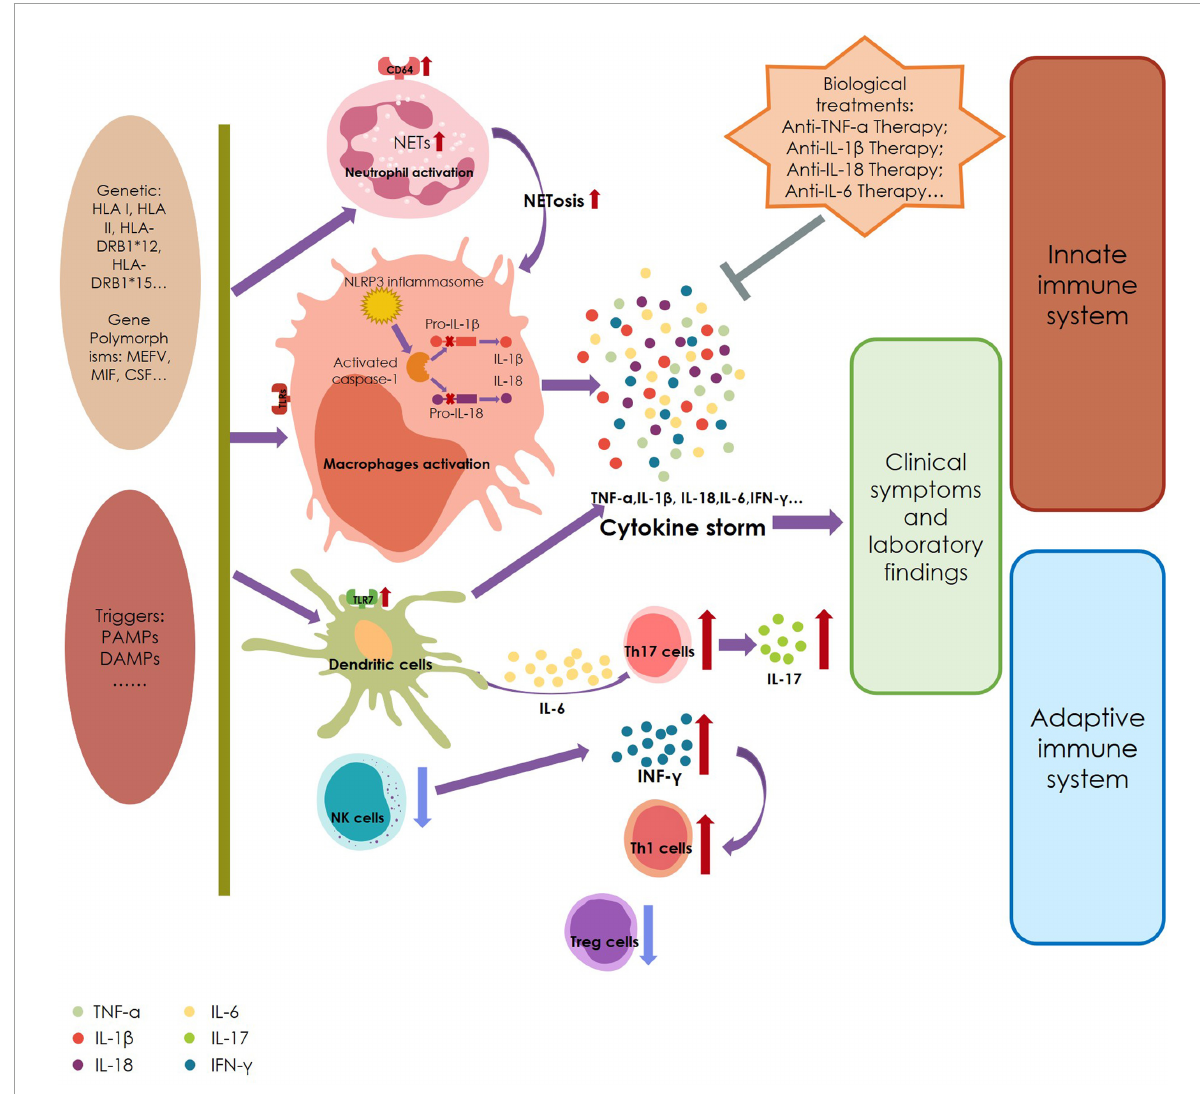
FIGURE2 A summary of the pathogenesis of adult-onset Still’s disease. HLA, human leukocyte antigen; MIF, migration inhibitory factor; CSF, colony-stimulating factor; PAMPs, pathogen-associated molecular patterns; DAMPs, damage-associated molecular patterns; TLR, Toll-like receptors; NETs, neutrophil extracellular traps; NLRP3, NLR3-containing a pyrin domain; NK cells, nature killer cells; IL, interleukin; TNF, tumor necrosis factor; INF,